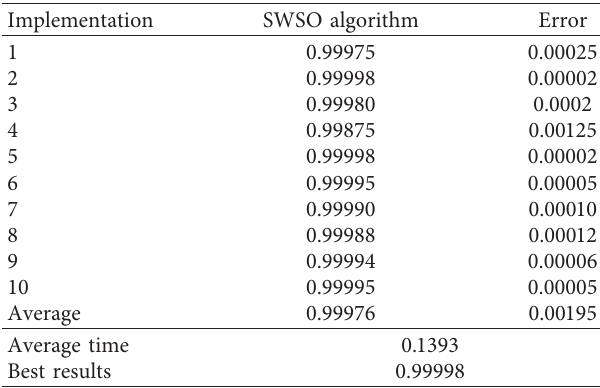
Figure 4: The three-dimensional jinc function. Table 1: Results of 10 independent run by SWSO algorithm.